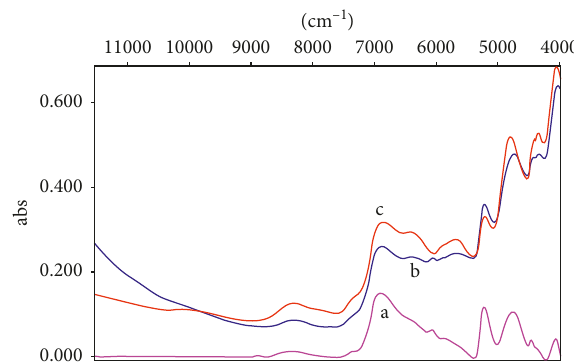
Figure 1: FT-NIR mean spectrum from the “outlier” (a), authentic (b), and adulterated (c) bilberry sample acquired from 4000 to 1 12500cm −